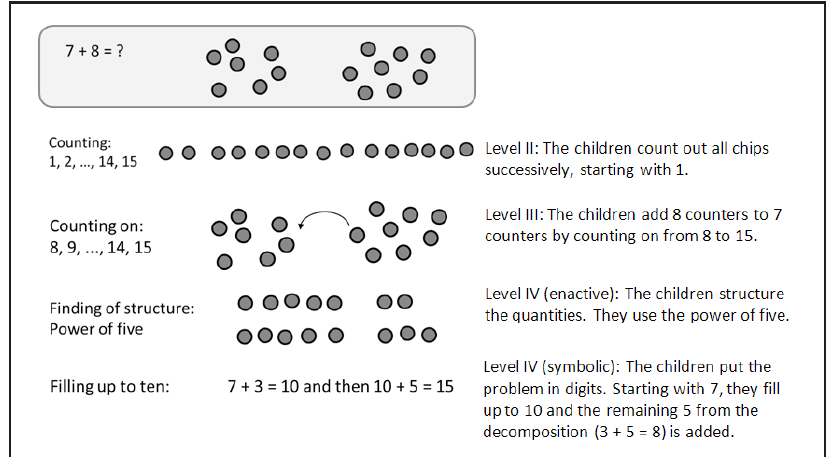
Figure 1: Strategies to solve an addition task, depending on level of mathematical